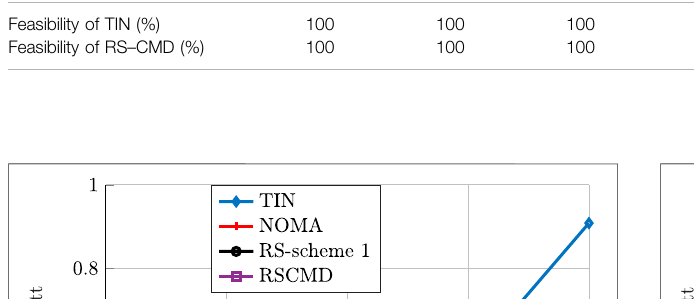
TABLE 3 | Percentage of feasible instances of the optimization problem (P 2 ) when deploying TIN and RS – CMD transmission strategies. Each BS is equipped with four antennas. r min k